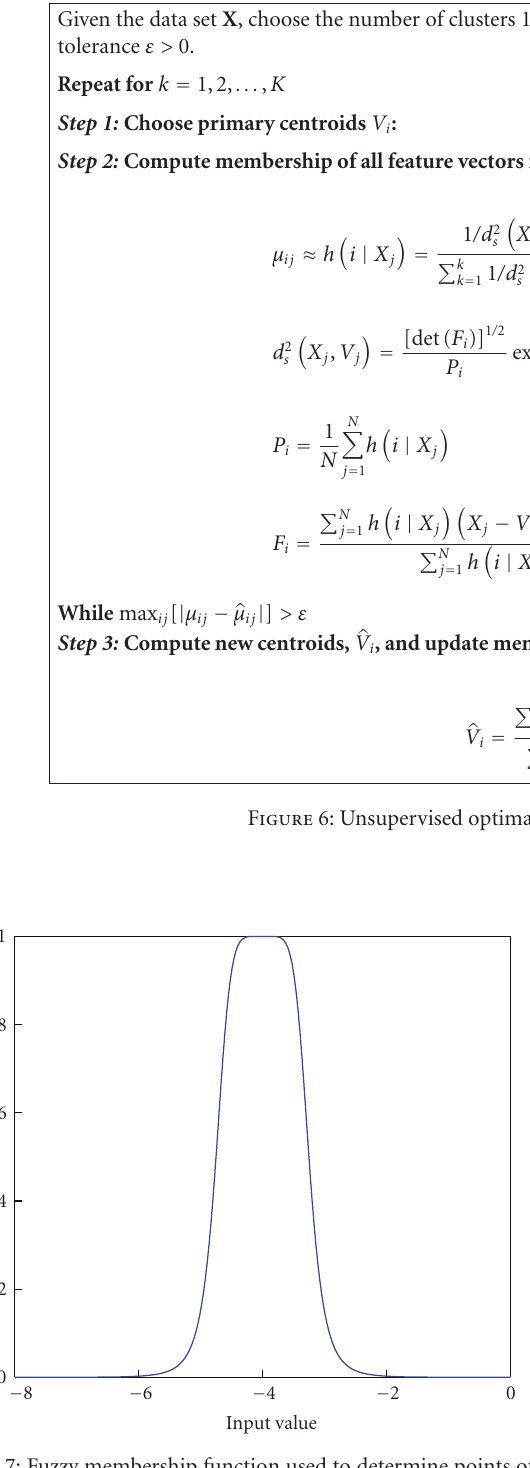
The parameters used for the gbellmf MATLAB function include the dataset and a vector describing the position and size of the membership function being